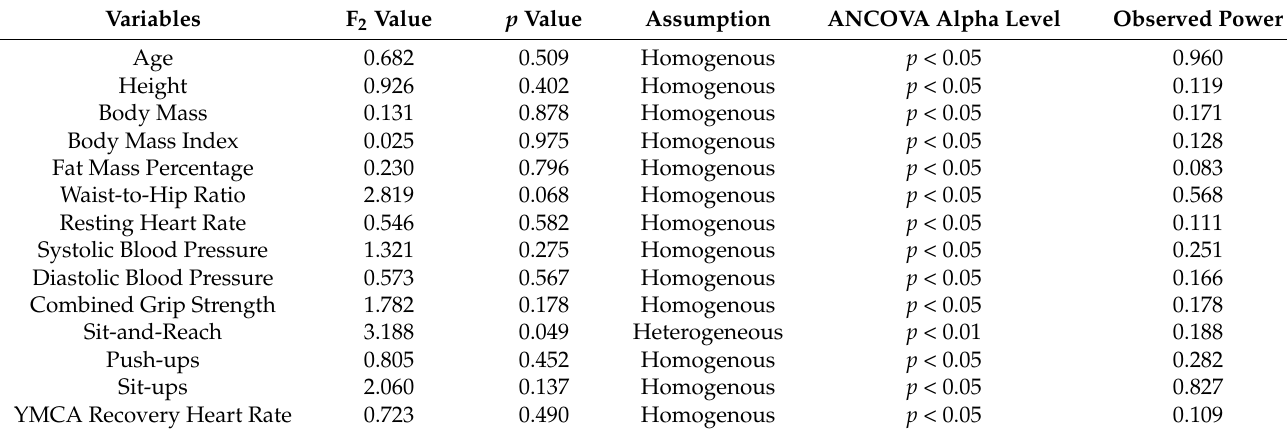
Table 1. Homogeneity of variance data from Levene’s test for equality of variances, and the resulting p value used for the ANCOVA, for age, height, body mass, body mass index, fat mass percentage, waist-to-hip ratio, resting heart rate, systolic and diastolic blood pressure, combined grip strength, sit-and-reach, push-ups, sit-ups, and recovery heart rate from the YMCA step test in law enforcement